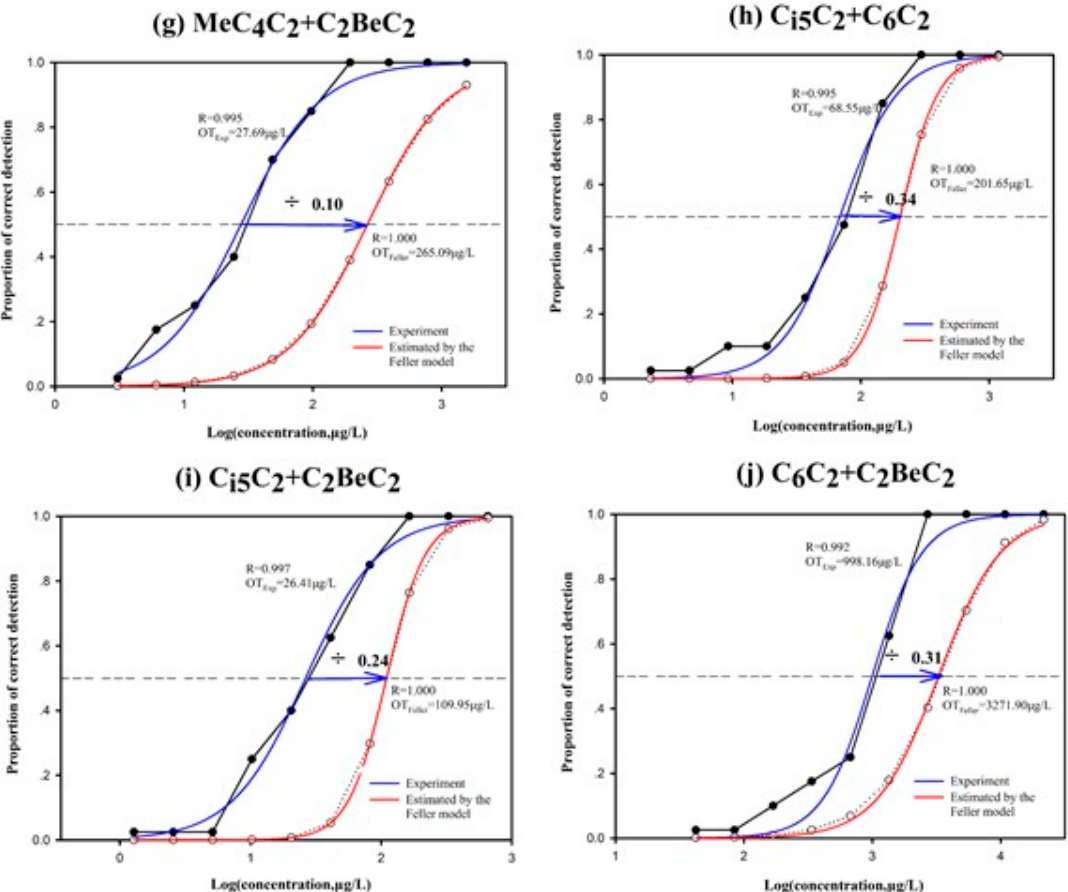
Figure 1. E ff ect of ethyl acetate and ethyl 2-methylbutyrate mixed ( a ), ethyl acetate and Ethyl 3-methyl butyrate mixed ( b ), ethyl acetate and ethyl hexanoate mixed ( c ), ethyl acetate and ethyl phenylacetate mixed ( d ), ethyl 2-methylbutyrate and Ethyl 3-methyl butyrate mixed ( e ), ethyl 2-methylbutyrate and ethyl hexanoate mixed ( f ), ethyl 2-methylbutyrate and ethyl phenylacetate mixed ( g ), Ethyl 3-methyl butyrate and ethyl hexanoate mixed ( h ), Ethyl 3-methyl butyrate and ethyl phenylacetate mixed ( i ), ethyl hexanoate and ethyl phenylacetate mixed ( j ). OT, olfactory threshold. The curves are drawn according to a sigmoid function. 2MeC 4 C 2 + C i5 C 2 , ethyl 2-methylbutyrate and ethyl 3-methyl butyrate mixed.